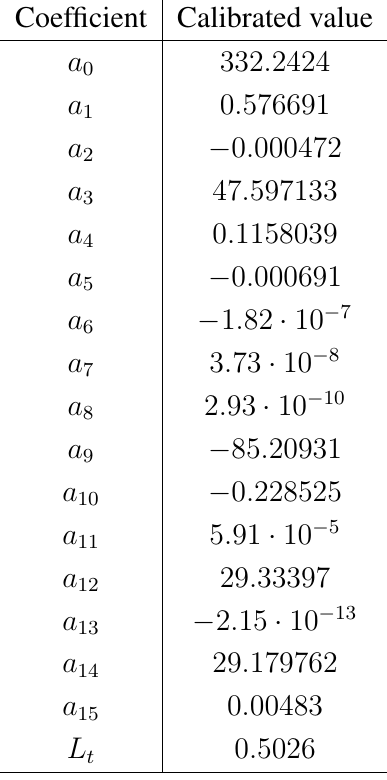
Table 2. Calibrated coefficients for Equation